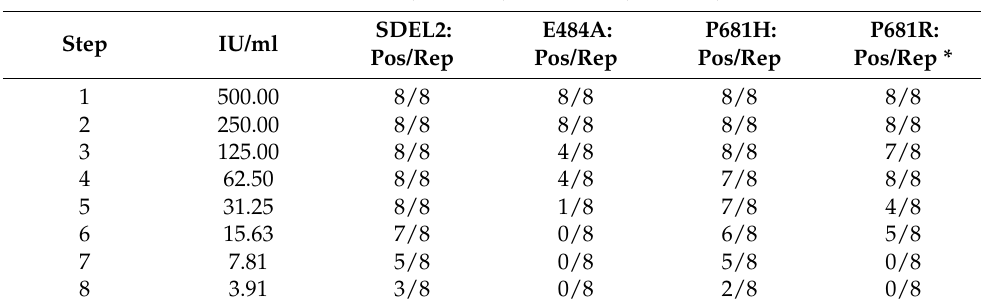
Table 3. LoDs were determined by serial dilution of a quantified Omicron variant cell culture stock and a clinical Delta variant sample, using the SARS-CoV-2 WHO standard (NBSCI, UK) as reference. Dilution series were generated automatically using a Hamilton STARlet IVD liquid handler. A 95% probability of detection was calculated using medcalc software. * P681R LoD constitutes a separate experiment using a quantified clinical sample of the B.1.617.2 lineage.